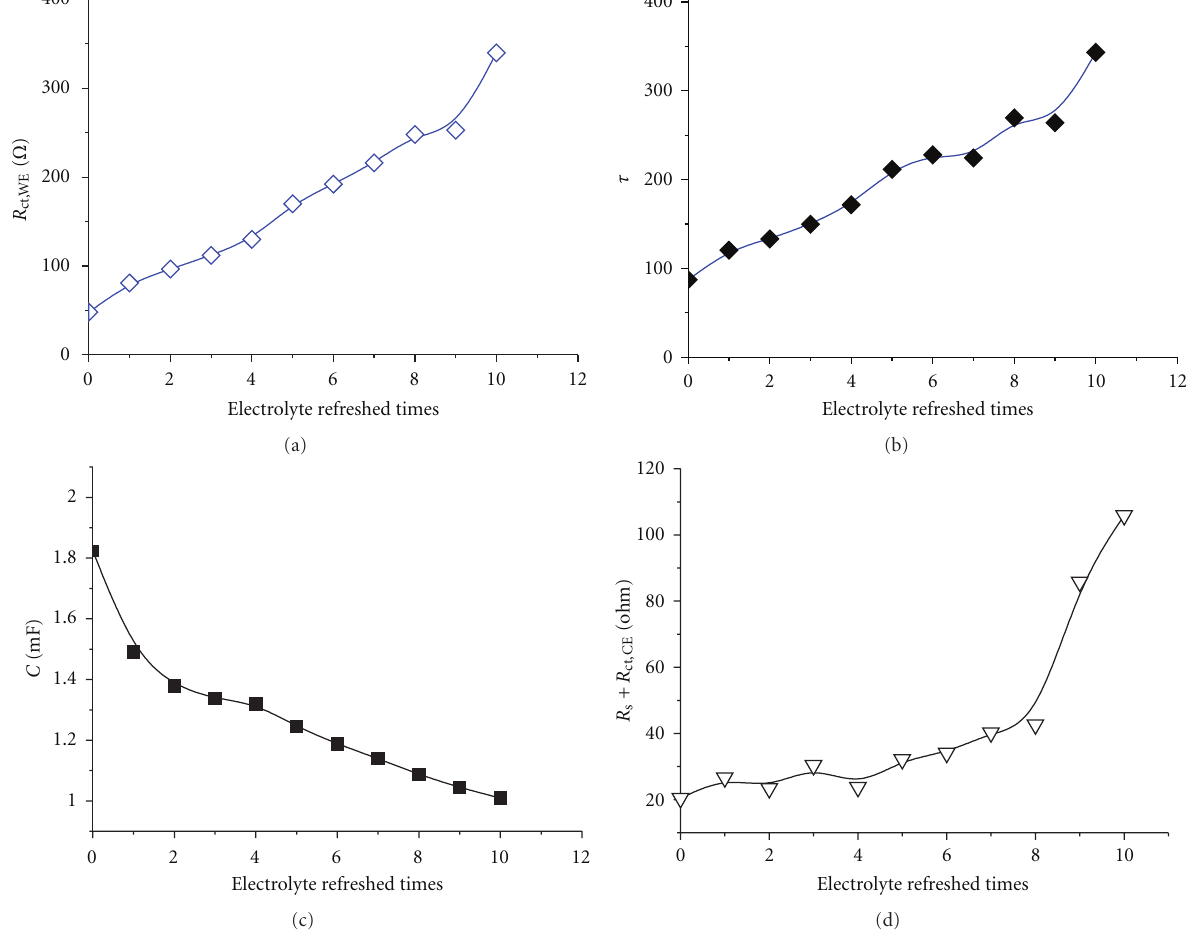
Figure 5: Characteristic parameters R ct,WE (a), electron life time τ (b), chemical capacity C (c), and R s + R ct,CE (d) of the arc impedance spectra of DSSCs with various electrolyte refreshing times in the dark at an applied forward bias of − 0.75